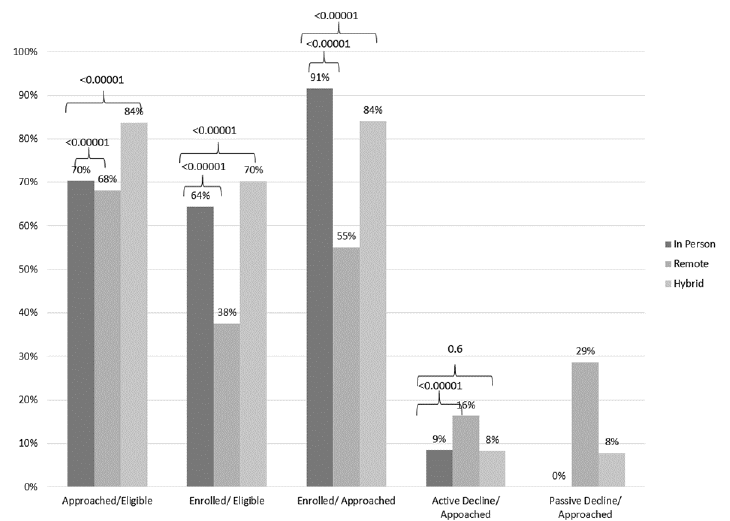
Figure 2. Approach and enrollment saturations and enrollment rates during pre-pandemic, fullre- mote and hybrid. Approach/Eligible is number approached as a fraction of total eligible babies with newborn screening (NBS), Enrolled/Eligible is number enrolled as a fraction of total eligible babies, Enrolled/Approached is number enrolled as a fraction of total approached, Active Decline/ Approached is the proportion who declined participation after being approached. Passive Decline/ Approached is the number who did not return a consent after being approached and agreeing to the study. The latter only exists for periods that had some remote recruitment. Recruitment